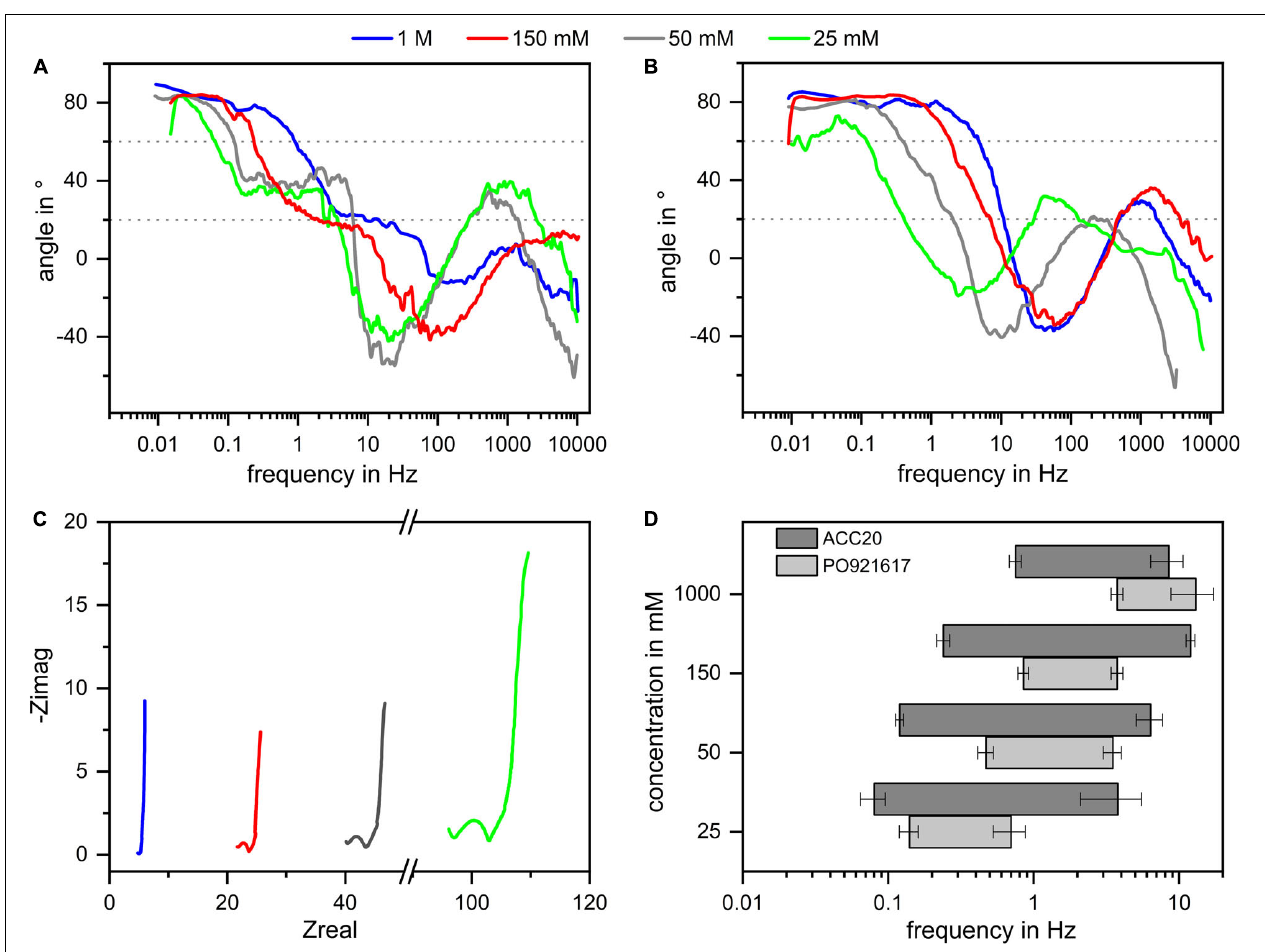
FIGURE 7 | Influence of the electrolyte concentration onto the diffusion dominated frequency range in EIS experiments. The NIF plots of the materials ACC20 (A) und PO921617 (B) are plotted for the concentrations 25, 50, 150, and 1000 mM as well as the Nyquist plot for ACC20 (C) and the frequency ranges (D) in which diffusion effect dominate the EIS results. Plot (A,B,D) clearly show that lower electrolyte concentrations shift the diffusion dominated frequency range toward lower